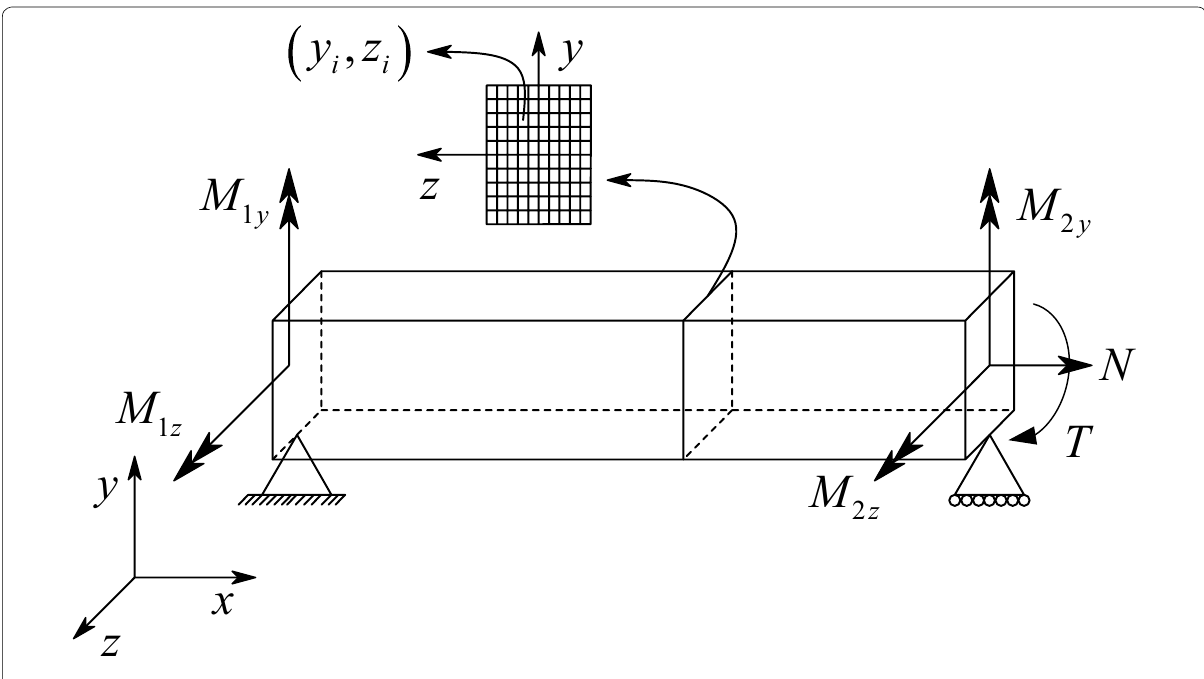
Fig. 2 The local coordinate system of modified force-based fiber